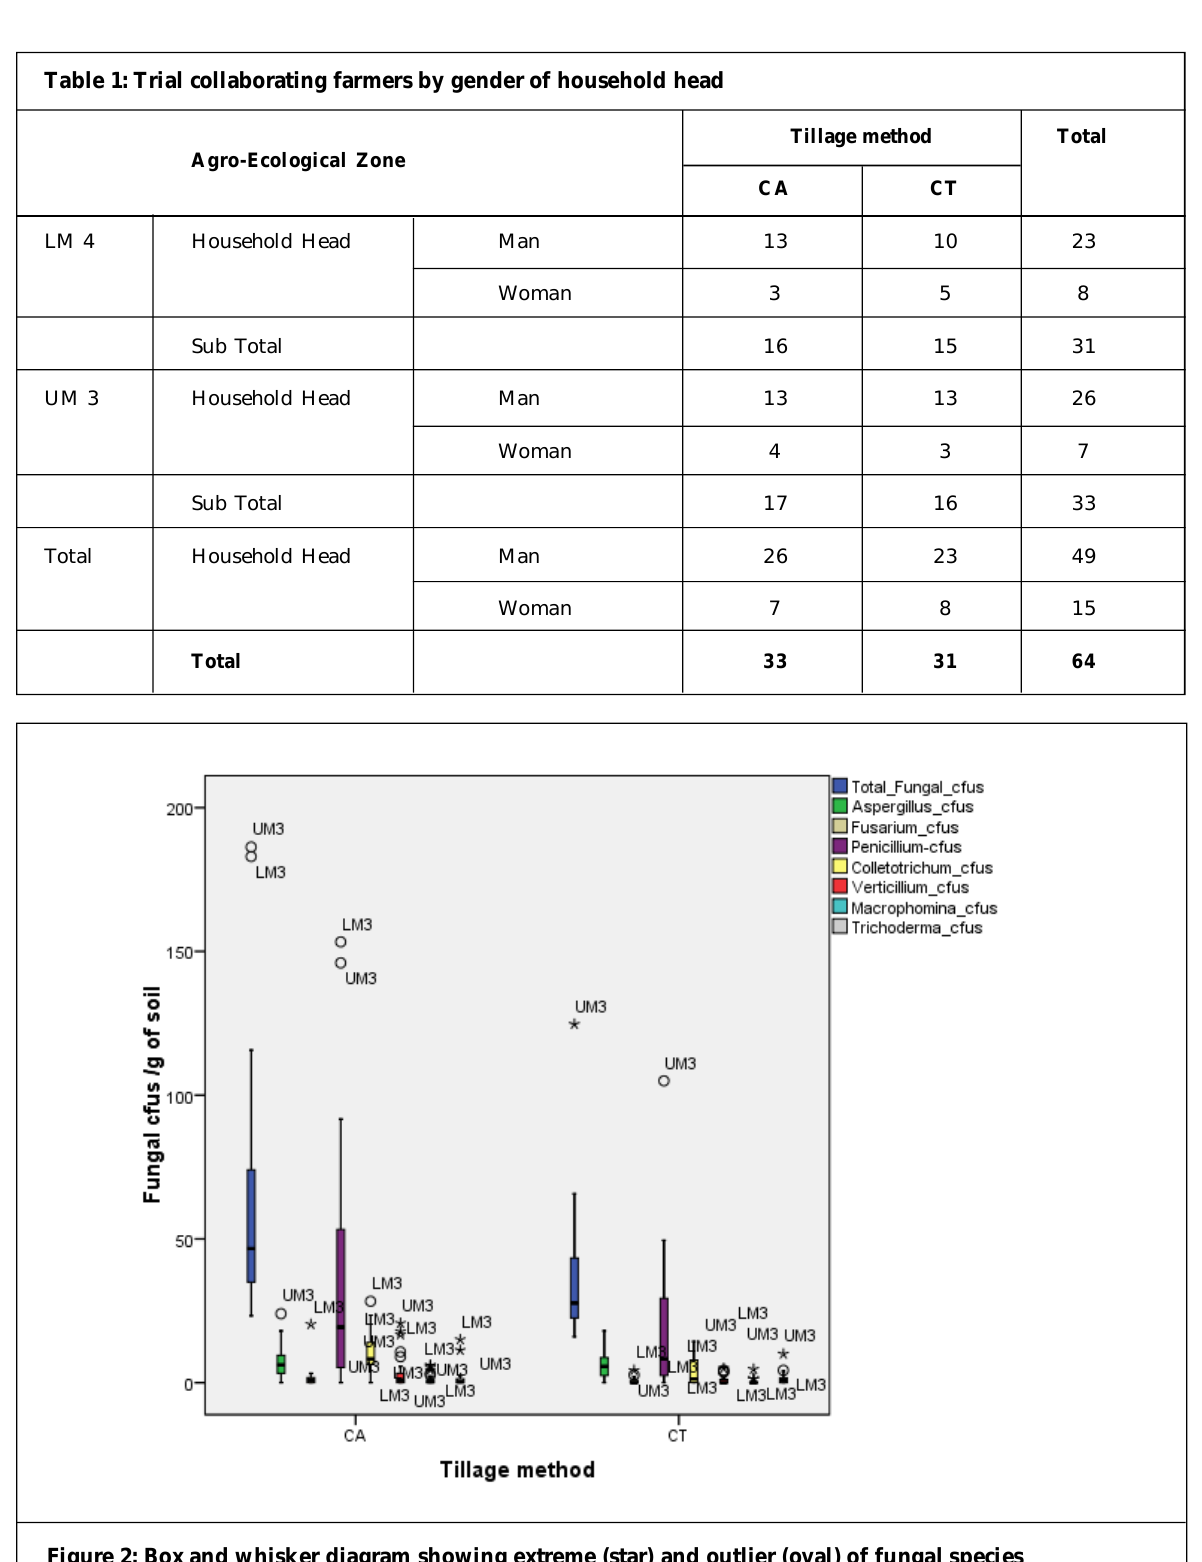
Figure 2: Box and whisker diagram showing extreme (star) and outlier (oval) of fungal species After removal of four outlier farms (Figure 3), three with very high fungal CFUs/g soil and one with very low fungal CFUs/g of soil, total fungal, Penicilium , Aspergillus and Colletotrichum CFUs/g of soil under both CA and CT passed the z-test (Kim 2013; Ghasemi and Zahediasl 2012) for normality of distribution. In addition, Aspergillus CFUs/g of soil under both CA and CT and Colletotrichum CFUs /g of soil under CA passed the Lilliefors corrected Kolomogorov-Smirnov tests for normality. These genera were found to be the most frequently detected on the trial farms and also had higher population densities in CFUs/g of